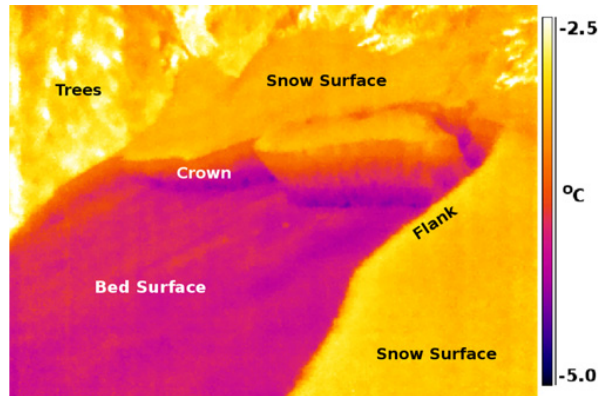
Fig. 1. Bed surface and crown of a slab avalanche, approximately 5min after release. The thermograph was taken approximately 3m from the labelled flank, and the crown depth is ∼